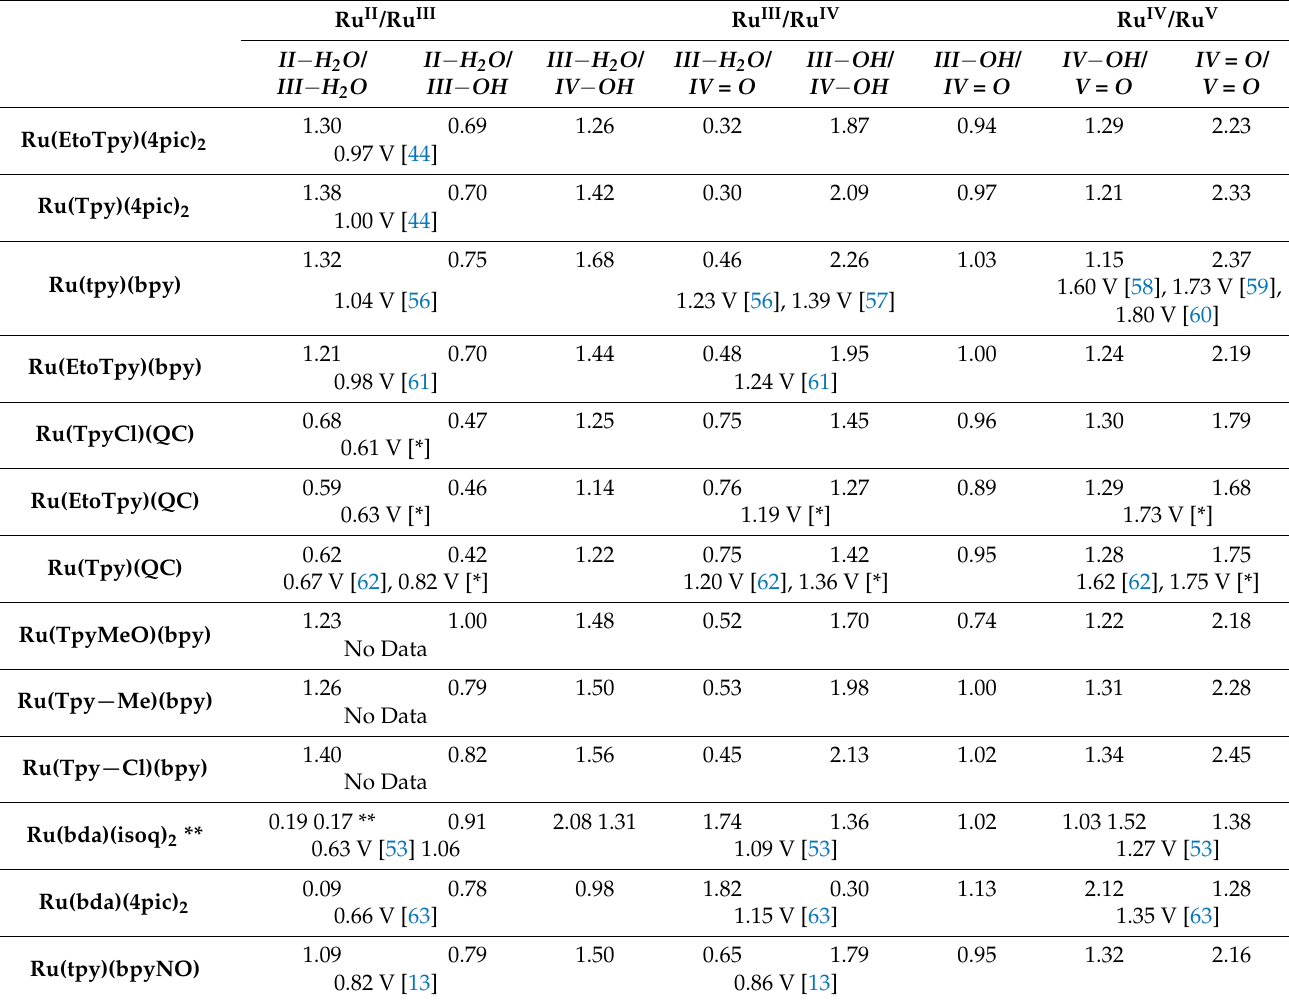
Table 1. Computed Redox potentials (V) for pH = 0 for each of the thirteen catalysts ET as well as PCET paths are considered. Ru II /Ru III Ru III /Ru IV Ru IV /Ru